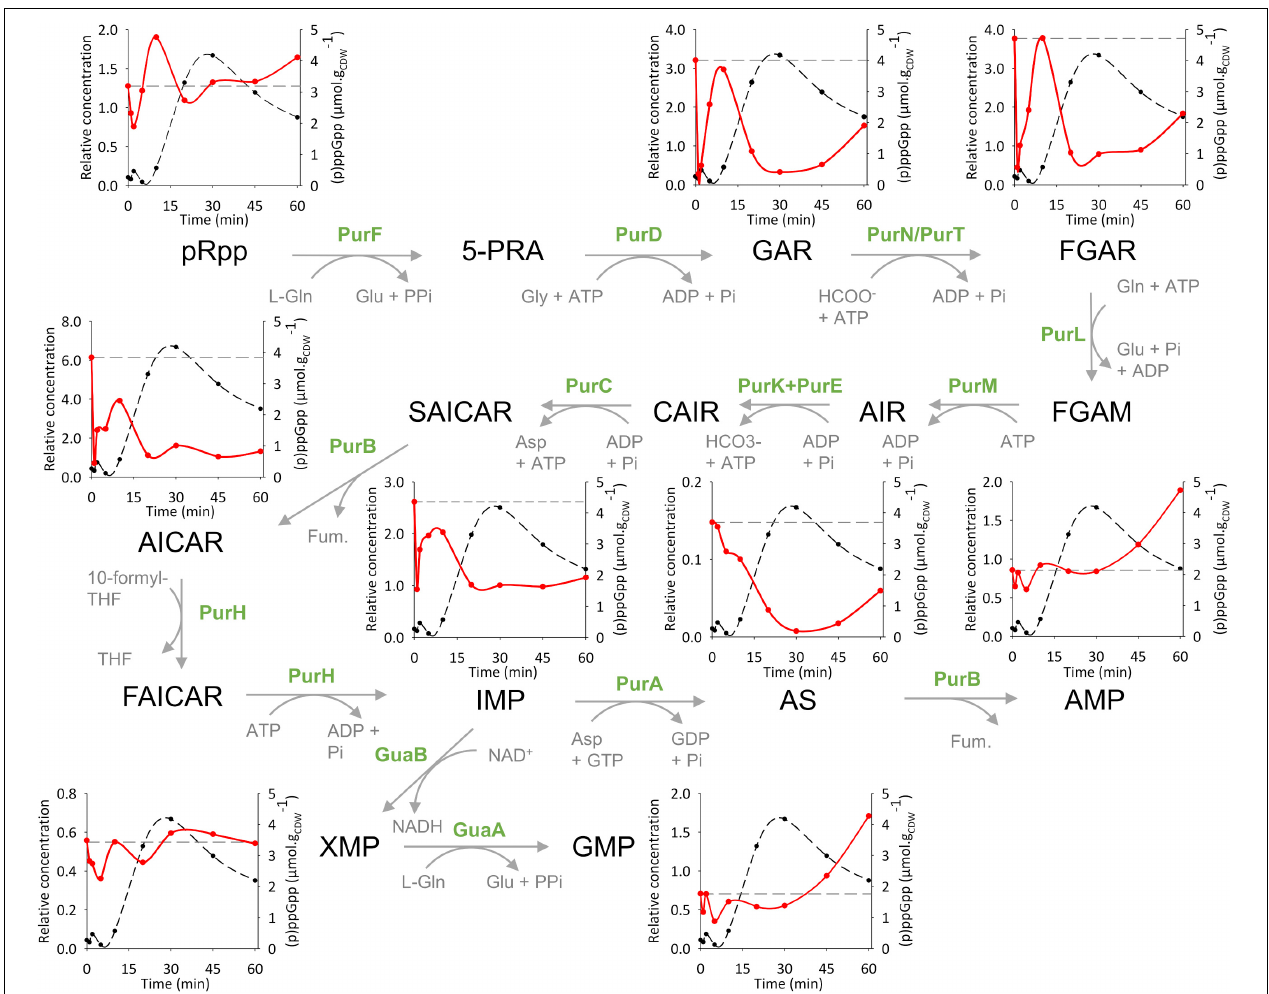
FIGURE 5 | (p)ppGpp acts as a metabolic regulator of the de novo purine synthesis pathways in P. putida . Metabolic pathway scheme for de novo purine synthesis. The inset graphs display the short-term concentration variations of pRpp, GAR, FGAR, AICAR, IMP, AS, AMP, XMP and GMP in wild-type P. putida KT2440 (red line) during the first phase of (p)ppGpp accumulation (black dots) in response to SHX addition. Metabolite concentrations are determined relative to the concentration of their U- 13 C labeled forms. The dashed gray lines on each graph show the baseline levels of the metabolites (i.e., intracellular levels before SHX addition). The results obtained from the other biological replicates are shown in Supplementary Figure 7 . Non-canonical abbreviations: pRpp: phosphoribosylamine; 5-PRA: 5-phosphoribosylamine; GAR: 5 (cid:48) -phosphoribosylglycinamide; FGAR: 5 (cid:48) -Phosphoribosyl- N -formylglycinamide; FGAM: 5 (cid:48) -Phosphoribosyl- N -formylglycinamidine; AIR: 5 (cid:48) -Phosphoribosyl-5-aminoimidazole; CAIR: 5 (cid:48) -Phosphoribosyl-4-carboxy-5-aminoimidazole; SAICAR: 5 (cid:48) -Phosphoribosyl-4-(N-succinocarboxamide)-5-aminoimidazole; AICAR: 5 (cid:48) -Phosphoribosyl-5-amino-4-imidazolecarboxamide; FAICAR: 5 (cid:48) -Phosphoribosyl-5-amino-4-imidazolecarboxamide; AS: Adenylosuccinate; Fum: Fumarate; Gln: Glutamine; Glu: Glutamate; Gly: